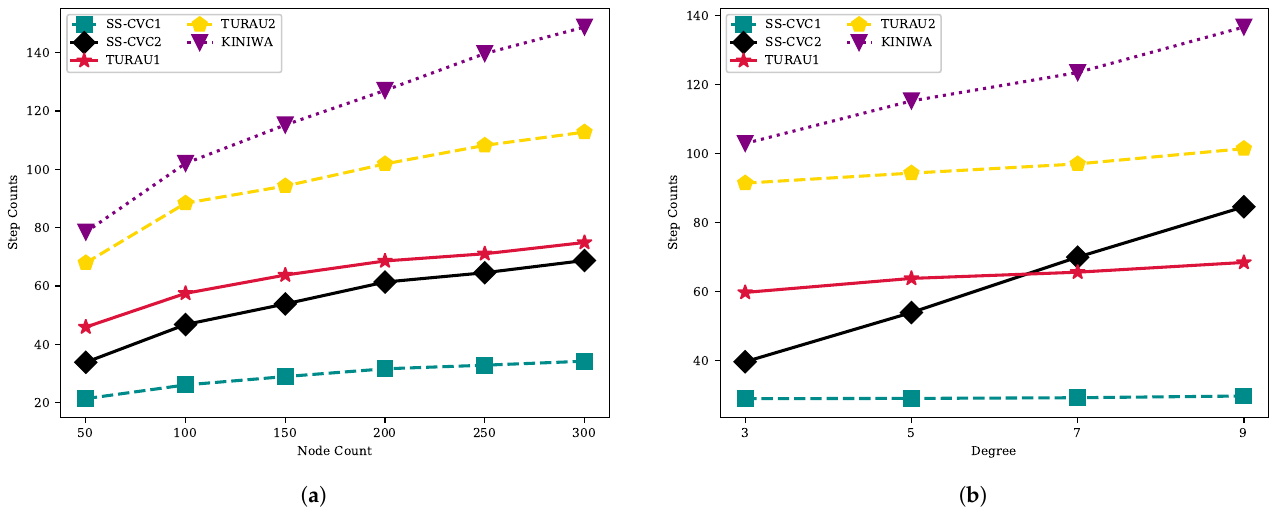
Figure 8. Move counts of algorithms on the weighted networks: ( a ) Step count against node count on the fixed average degree 5; ( b ) Step count against node count on the fixed network size 150. Figure 9 depicts the sent bytes for each algorithm on the whole network in kB. The SS-CVC 1 and SS-CVC 2 algorithms need the lowest message passing traffic related